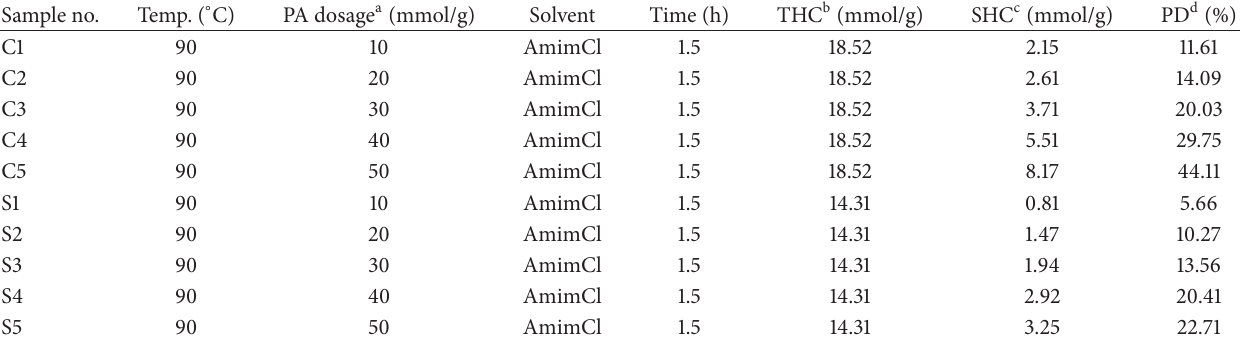
Table 1: The substituted hydroxyl contents and phthalation degrees of the phthalated cellulose and bagasse. Sample